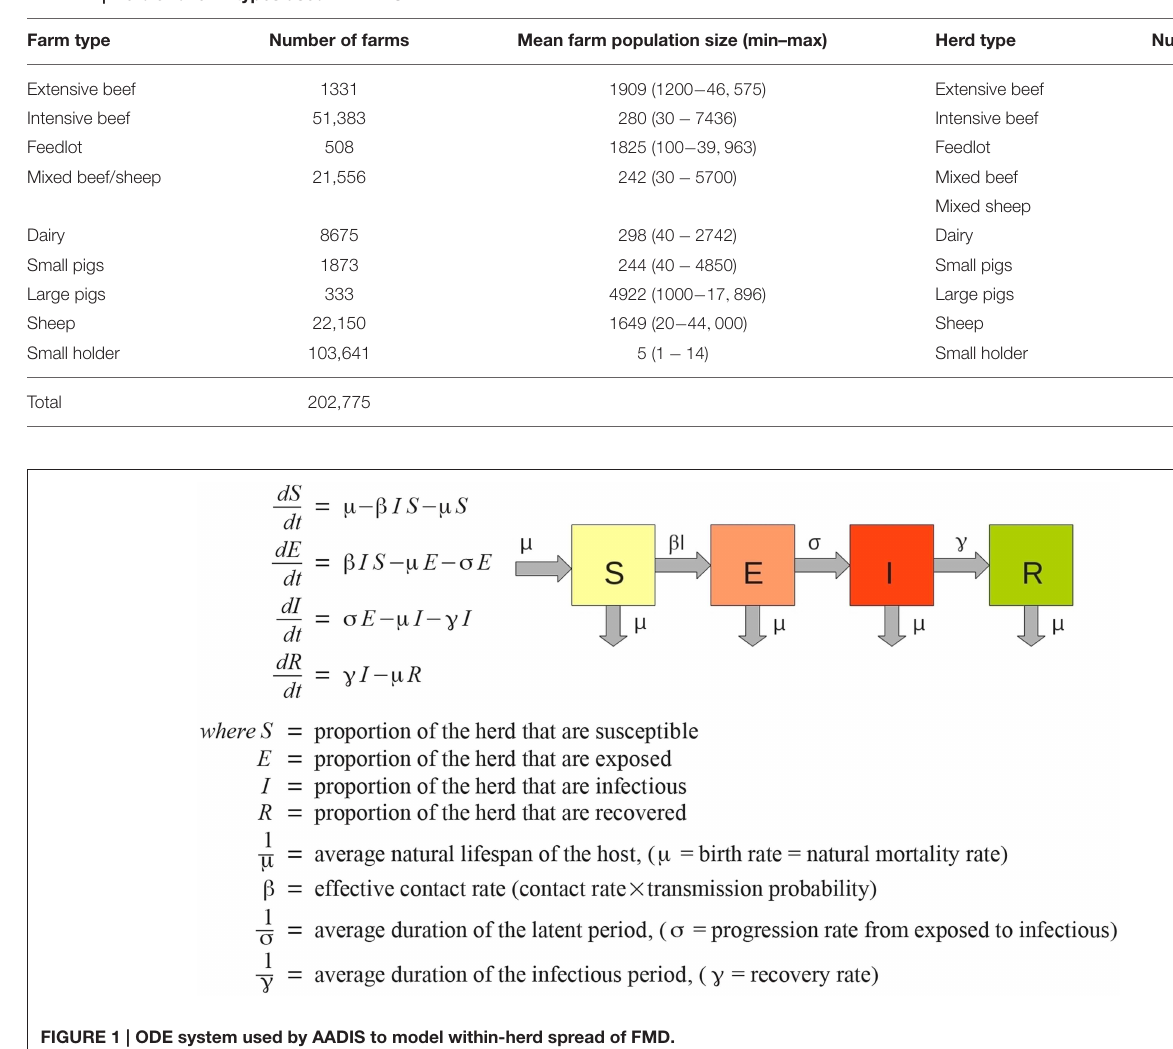
TABLE 1 | Herd and farm types used in AADIS.